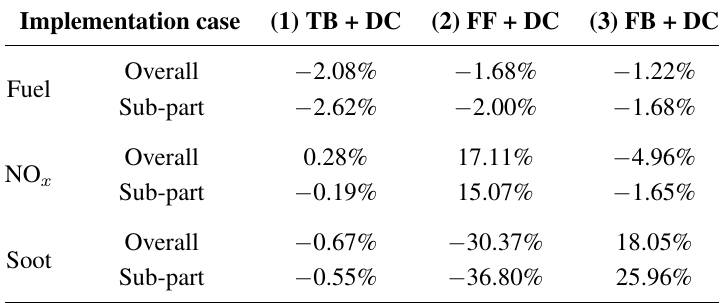
Table 6. Performance of the compensation-map based control systems on the validation cycle, in terms of relative change with respect to reference trajectories.